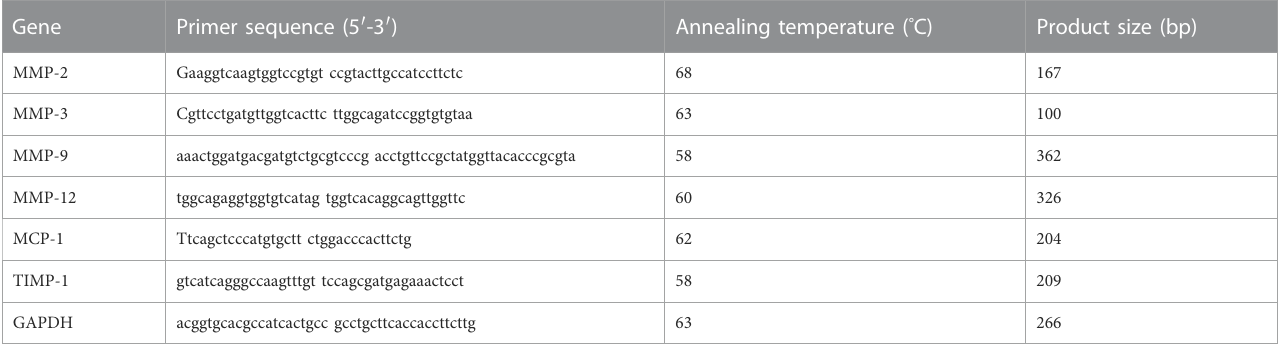
TABLE 1 Primer sequences and ampli fi cation conditions for real-time RT-PCR. Gene Primer sequence (5 ′ -3 ′